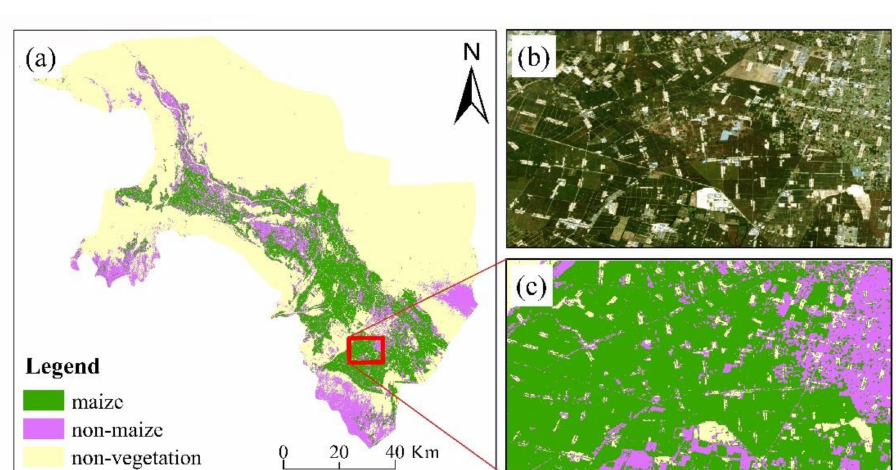
Figure 6. ( a ) Distribution map of maize planting area in the study area; ( b ) The false color composite map of a local enlarged typical desert-oasis zone; and ( c ) maize distribution map of the typical